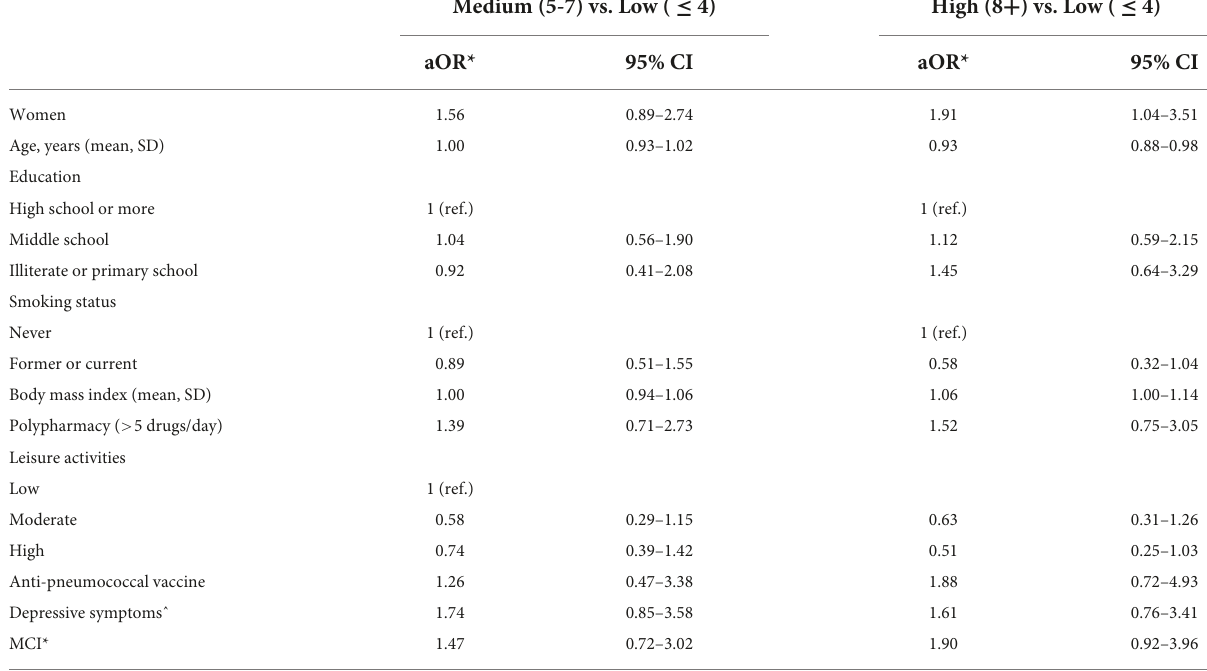
TABLE 3 Multinomial logistic regression model between baseline characteristics of participants and the tertiles of score fear.